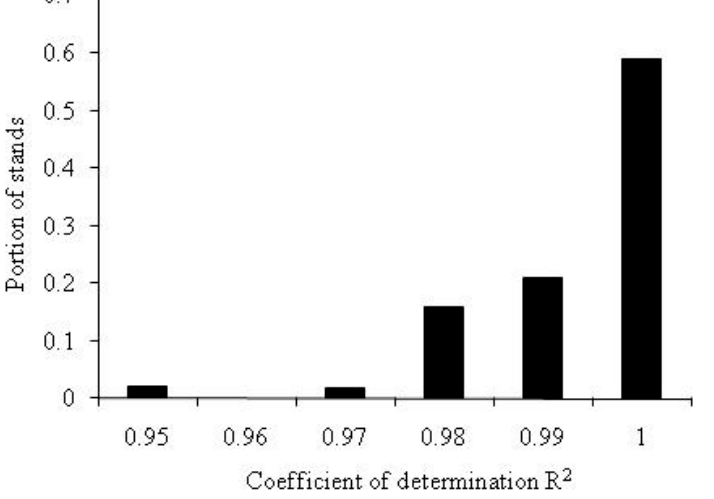
Figure A2. The distribution of the coefficient of determination R 2 of the linearized Zipf-Pareto Equation (A2) for the phytomass distribution among tree components.